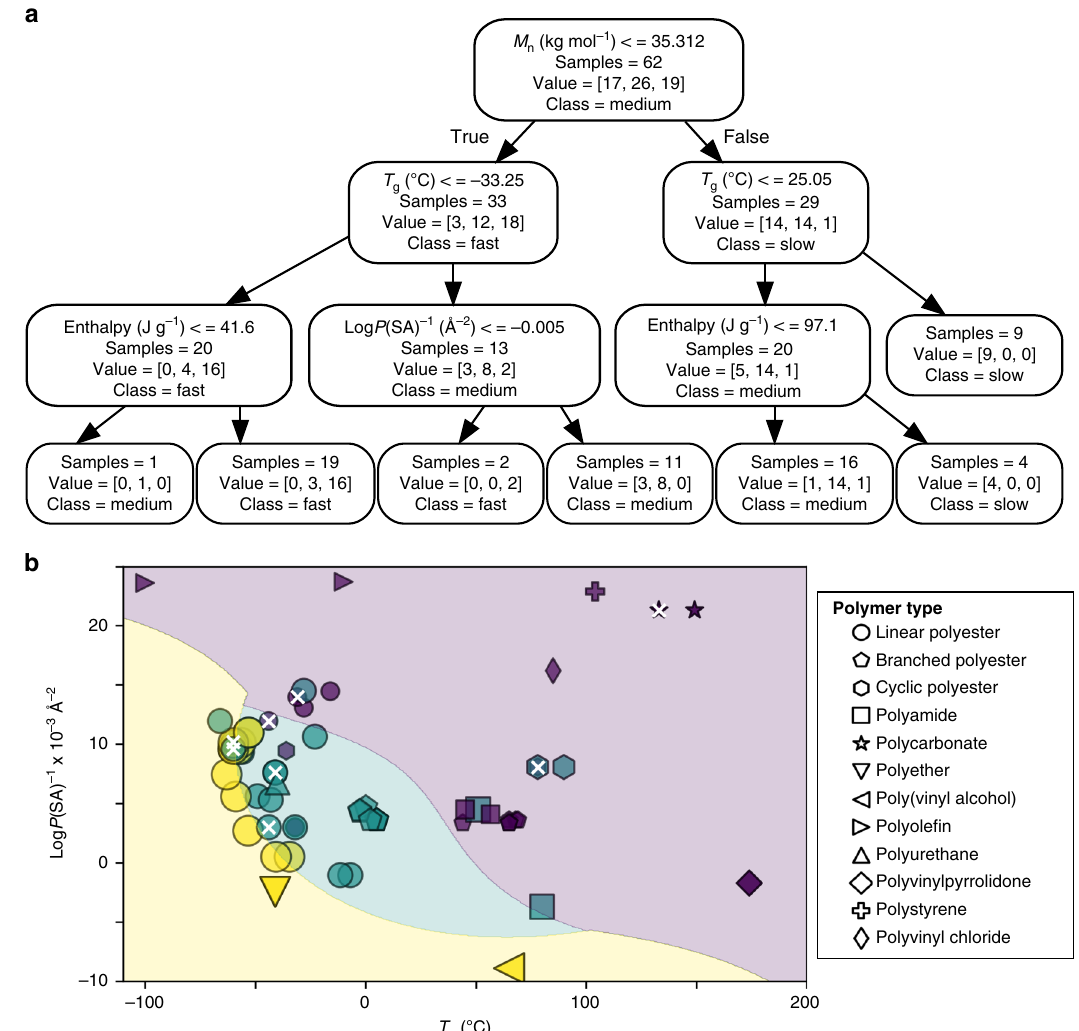
Fig. 5 Machine learning results with 3-levels of classi fi cation. a Decision tree based on molecular weight, enthalpy, Log P (SA) − 1 , and T g . Within each box of the tree, value = [x, y, z] corresponds to [slow, medium, fast]. b Graphical representation of two of the four features. The shaded areas, added to visually generalize the degradation regions, correspond to fast (yellow), medium (green), and slow (purple) degradation. Incorrect predictions from the classi fi cation tree are denoted with an ‘ x ’